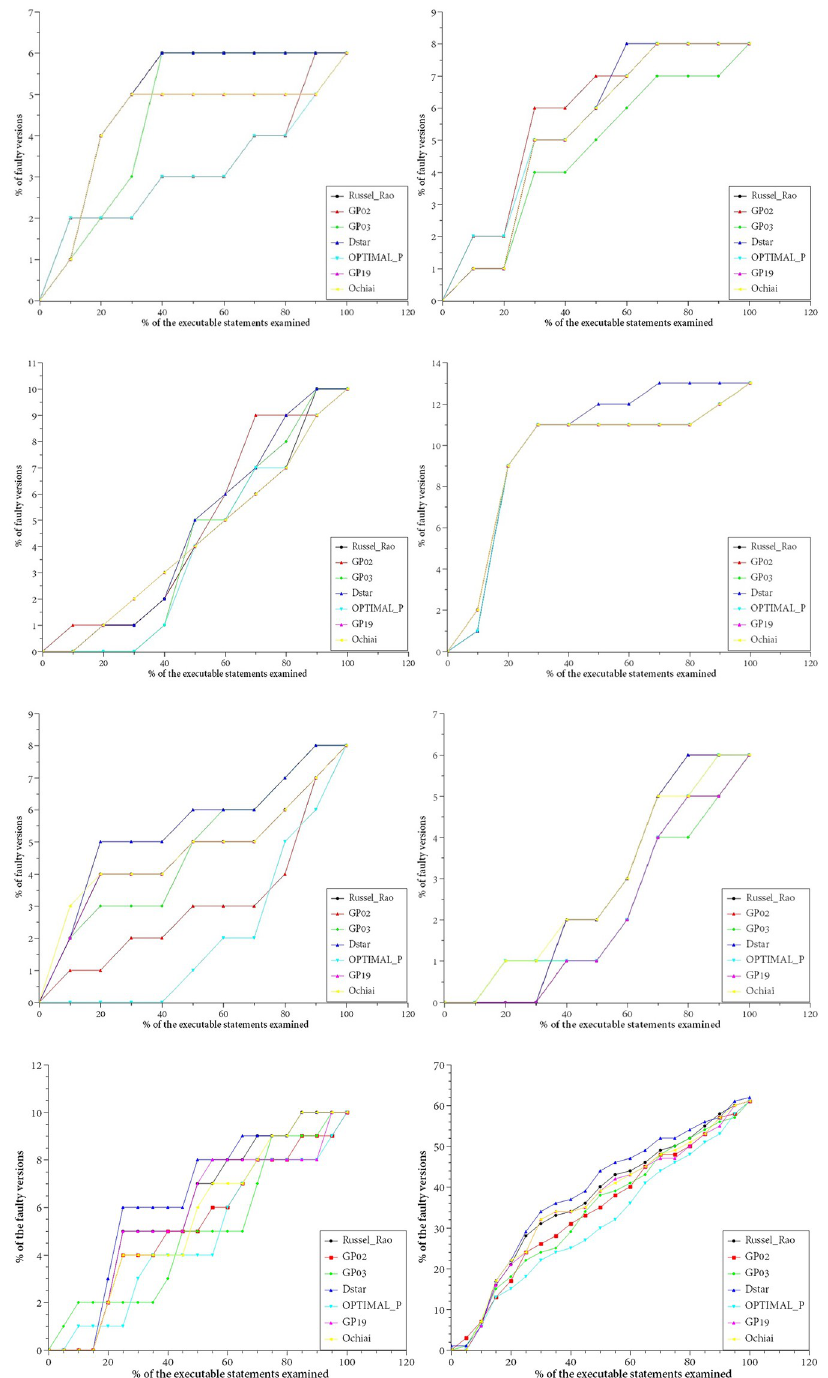
Fig 4. EXAM comparison of seven evaluation metrics. (a): The EXAM Comparison on AES. (b): The EXAM Comparison on Cordic. (c): The EXAM Comparison on FPU. (d): The EXAM Comparison on SHA256. (e): The EXAM Comparison on Pci. (f): The EXAM Comparison on Uart. (g): The EXAM Comparison on USB. (h): The EXAM Comparison on all faulty